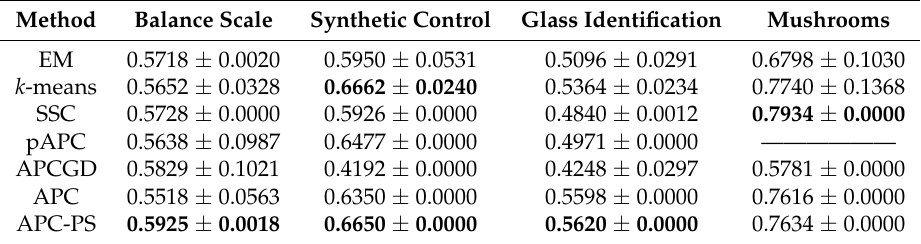
Table 2. Experimental results (average ± standard deviation) on UCI datasets under evaluation metric Fmeasure . The numbers in boldface denote the best performance.